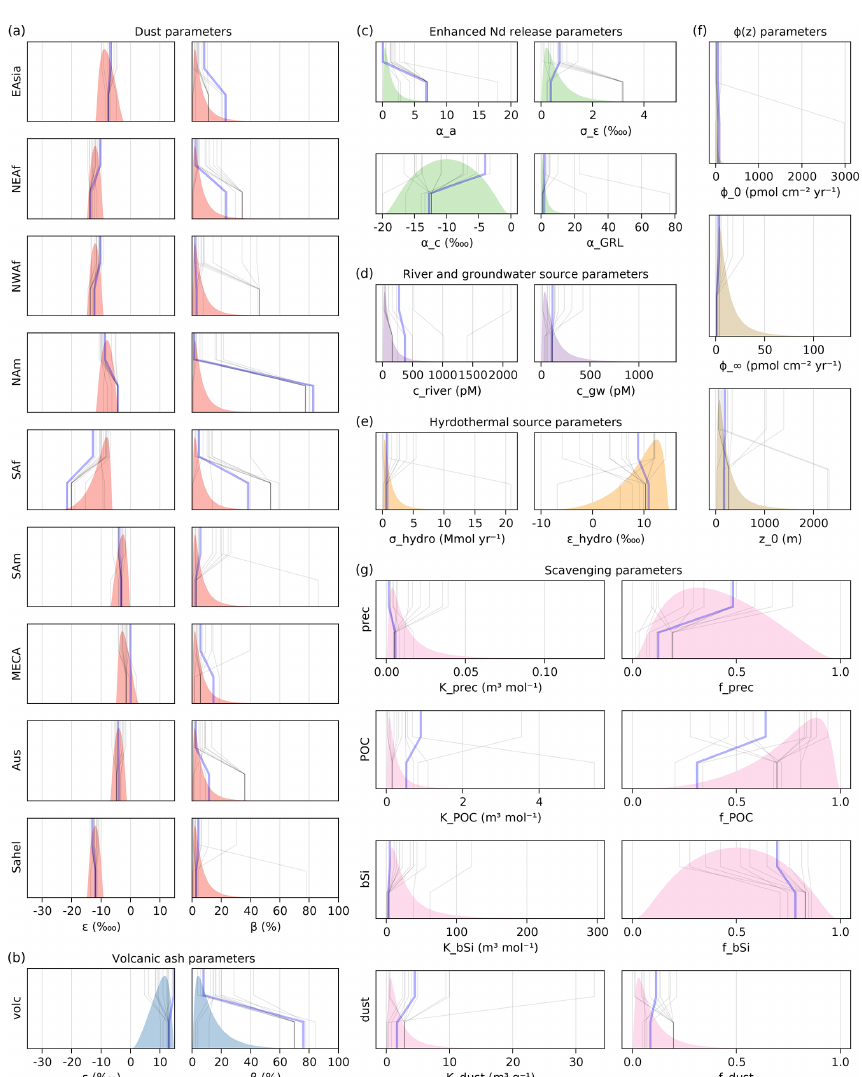
Figure B1. Parameter prior distributions (color-filled densities) and initial and optimized parameter values for a dozen of optimization runs (lines). Each line starts by showing the initial parameter value at the top and is connected to the final optimized value at the bottom. The thicker blue line represents the optimization run that was used as our best estimate. (a) Dust ε Nd values ( ε r ) and solubilities ( β r ) for each region of origin r . (b) Volcanic ash ε Nd value ( ε volc ) and solubility ( β volc ). (c) Enhanced Nd release parameters, α curve parameters (curvature α a and center α c ), Greenland enhancement ( α GRL ), and global standard deviation of per-grid-cell in situ sedimentary ε Nd ( σ ε ). (d) Rivers and groundwater Nd concentrations ( c river and c gw ). (e) Global hydrothermal source magnitude ( σ hydro ) and ε Nd ( ε hydro ). (f) Sedimentary flux parameters ( φ 0 , φ ∞ , and z 0 ). (g) Reversible scavenging reaction equilibrium constants, K X , and fractions returned to water when reaching seafloor, f X , for each particle type X . See also Table